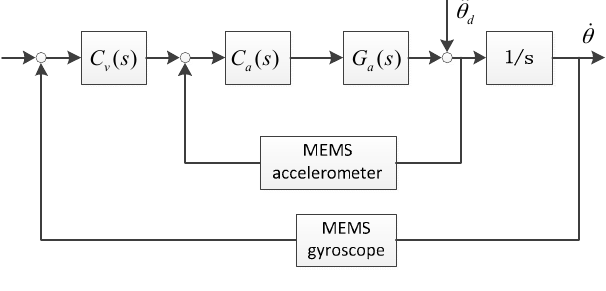
Figure 3. MEMS control system.